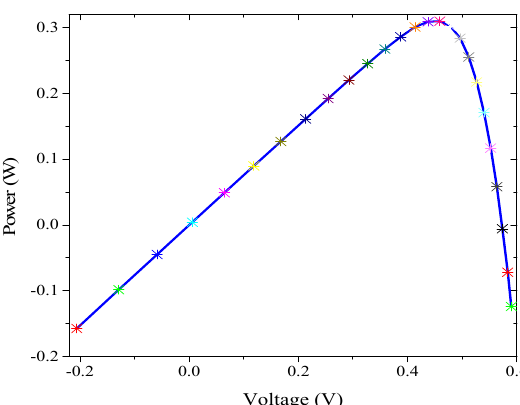
Figure 8. I–V curve of the measured and calculated currents for the double-diode cell.